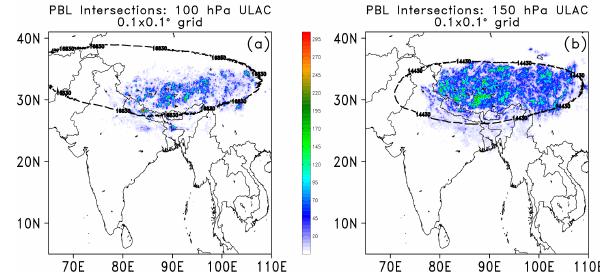
Fig. 6. Locations where convective back trajectories originating at 100hPa (a) and 150hPa (b) cross the PBLH, binned into 0.1 ◦ × 0.1 ◦ cells. The dashed contour at each pressure altitude rep- resents the time-averaged location of the ULAC during the simu- lation. The color bar indicates the number of trajectories that cross the PBLH in each 0.1 ◦ × 0.1 ◦